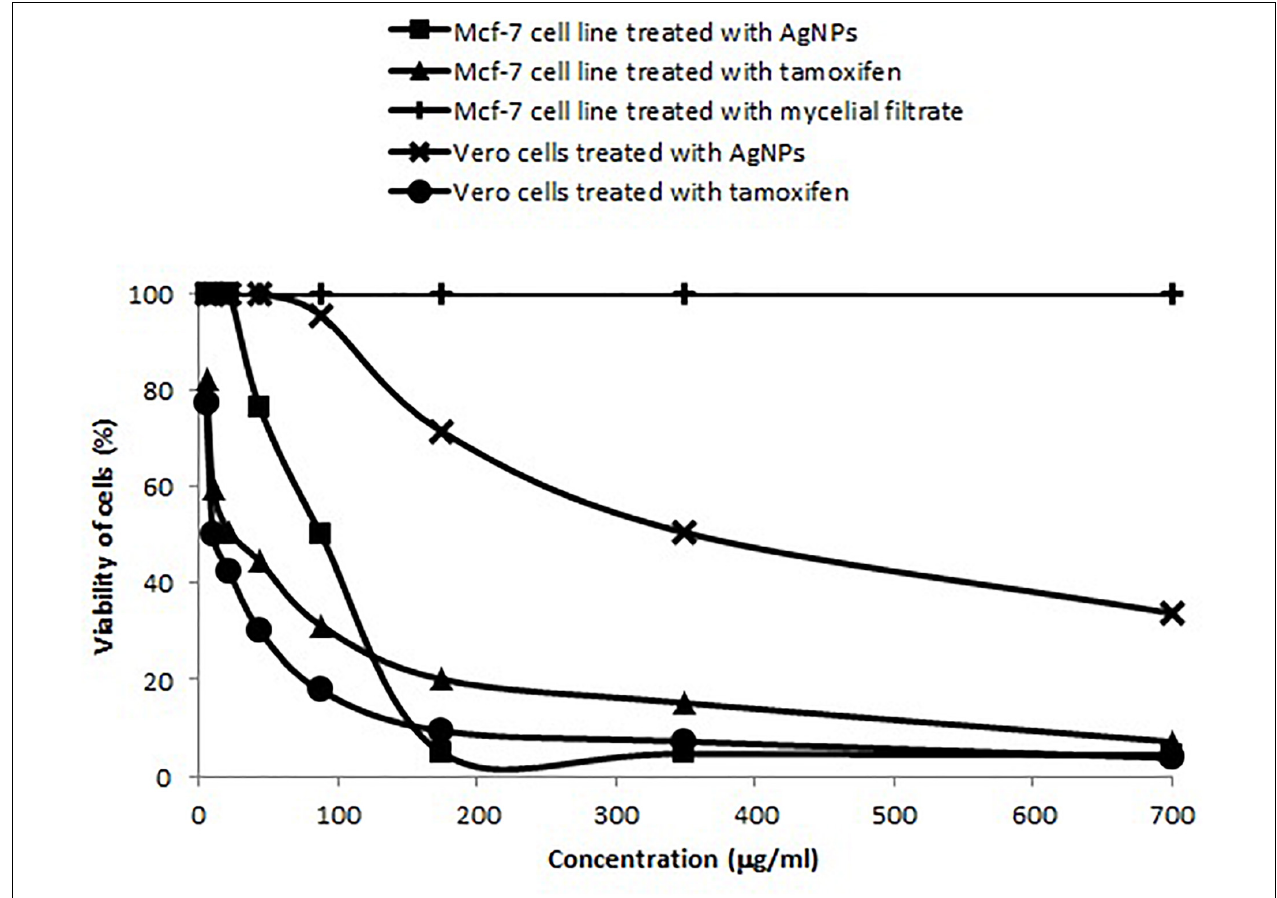
FIGURE 11 | Concentration dependent cytotoxic effects of AgNPs synthesized by A. terreus BA6 and tamoxifen on adenocarcinoma human breast cells (Mcf-7).